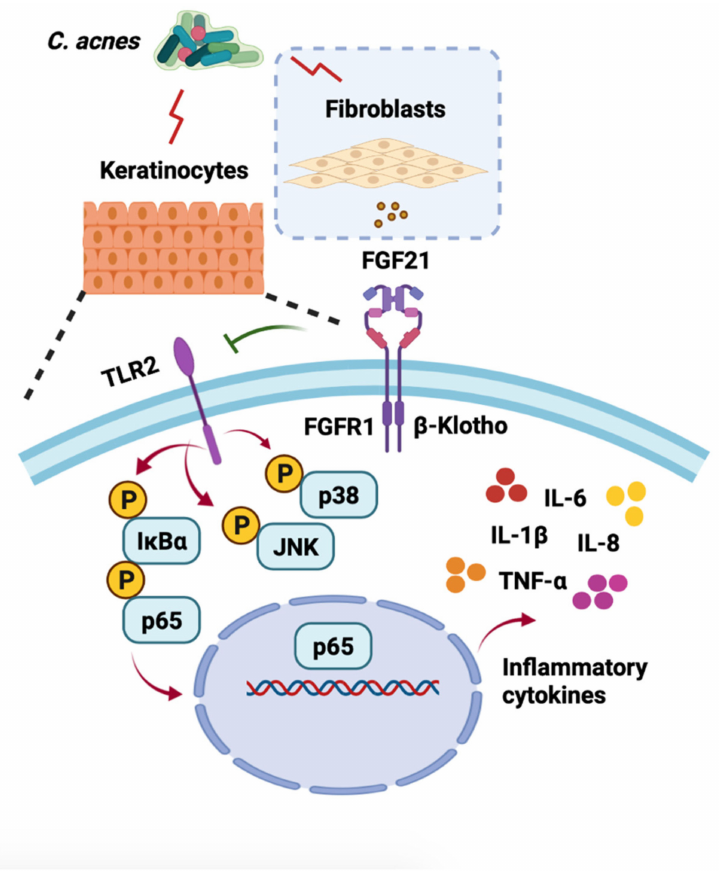
Figure 8. Proposed mechanism of action of FGF21 in C. acnes -induced skin disease. Under the induction of C. acnes , FGF21 secreted from fibroblasts inhibits TLR2, NF-KB, and MAPK signaling and inflammatory factors in keratinocytes by activating FGFR1 and KLB, and exogenous treatment by FGF21 can also relieve a series of inflammatory reactions induced by C. acnes